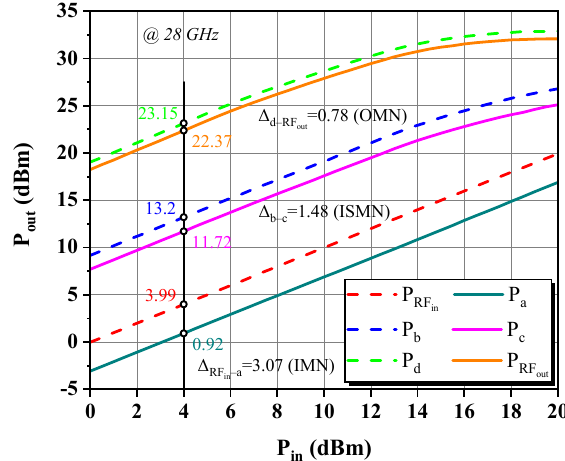
Figure 17. Simulated P out at various nodes of the DA at 28 GHz.